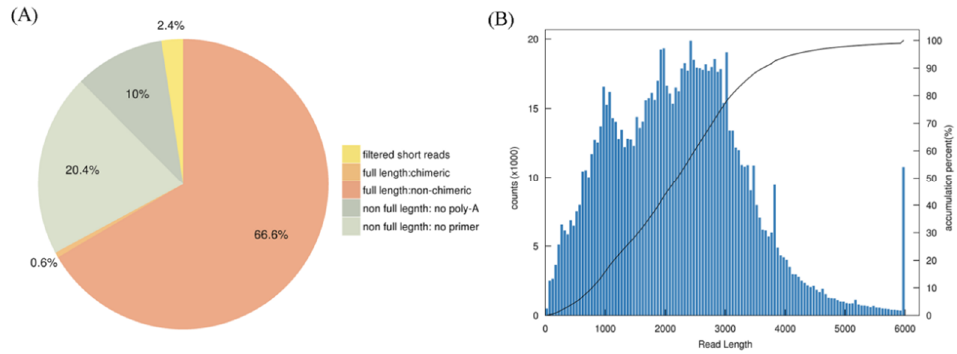
Figure 1. The reads of insert (ROI) classification ( A ) and ROI reads length distribution ( B ) for the 1–6 K selected library. ( A ) In a pie chart, the sectors with five colors represent filtered short reads, full-length chimeric reads, full-length non-chimeric reads, non-full-length reads with no poly-A and non-full-length reads with no primer, respectively. The ratio of each sector to circular area represents the ratio of the corresponding type. ( B ) The xlab stands for the length of ROIs. The left ylab represents the reads counts within the corresponding length range and the right ylab represents the cumulative frequency of the corresponding read length.